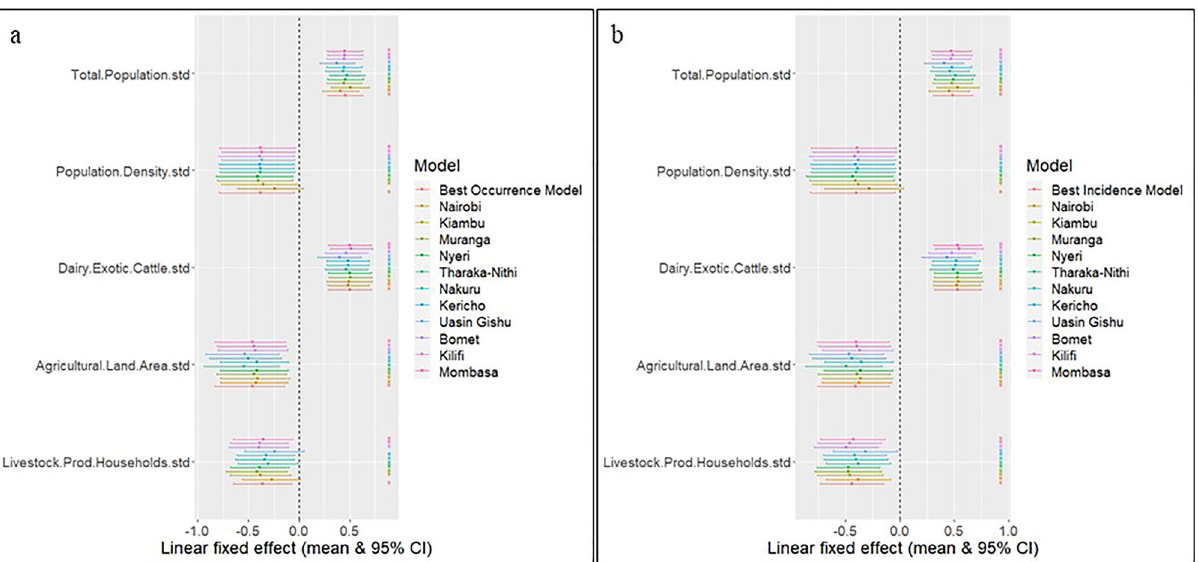
Figure 10. Geographical cross-validation tests for model robustness. The figures show the magnitude and direction of the fixed effect across all the holdout models to test whether the findings were overly influenced by data from any geographical location. The figure was generated using R software v. 4.1.0 28